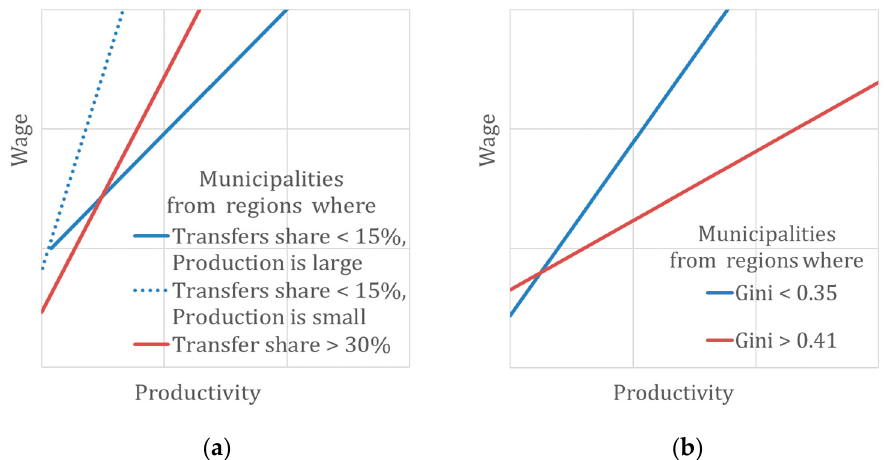
Figure 7. The relationship between wage and production volume at municipal scale under the influence of regional factors: share of social transfers ( a ) and Gini coefficient ( b ). The lines describing the relationship of indicators at the municipal level were built using the OLS method, not for all groups but only for several ones with the highest and lowest values of the indicators. The influence of other factors was not taken into account.